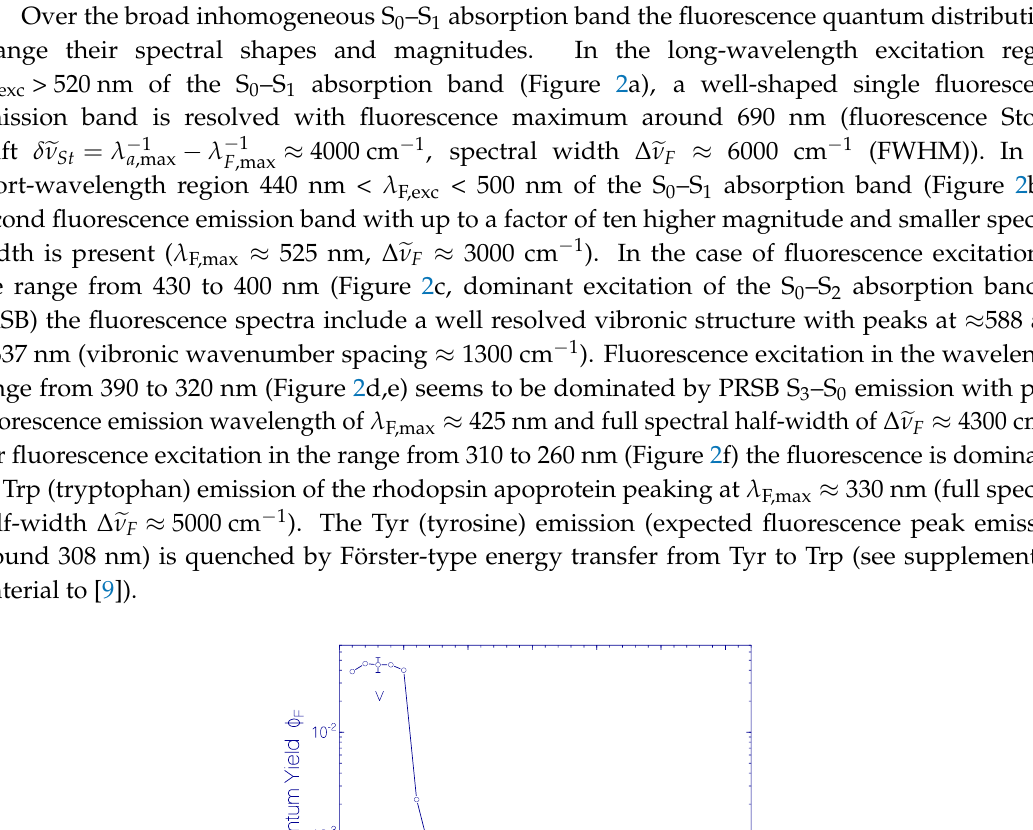
Figure 2. Fluorescence emission quantum distributions E F ( λ ) of fresh centrifuged CaRh in pH 7.3 HEPES/MOPS buffer for various fluorescence excitation wavelengths in the regions from ( a ) 540 to 520 nm; ( b ) 500 to 440 nm; ( c ) 430 to 400 nm; ( d ) 390 to 360 nm; ( e ) 350 to 320 nm, and ( f ) 310 to 260 nm. Numbers I – V indicate origins from different excitation transitions.